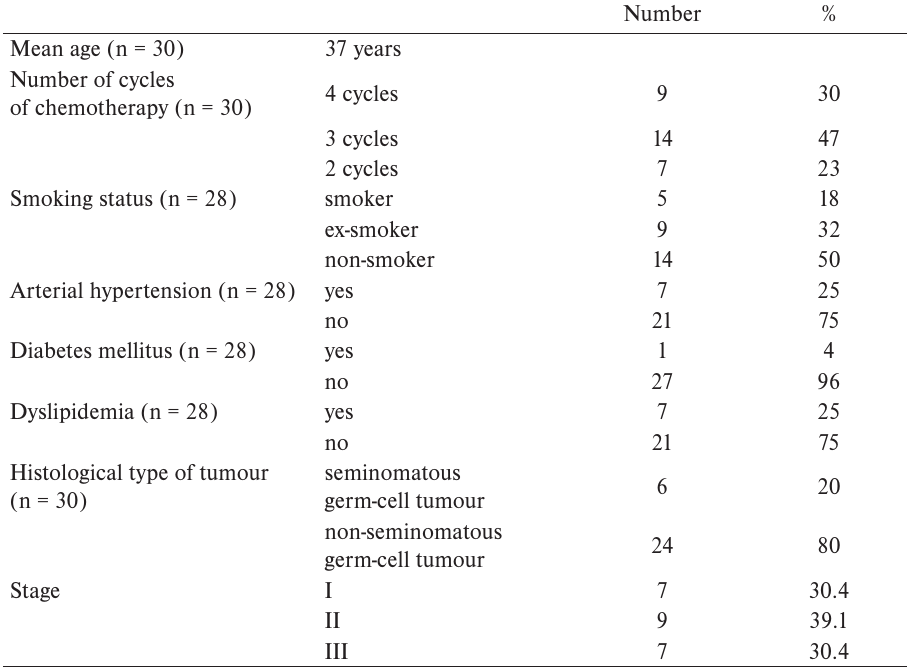
Table 1. Characteristics of study